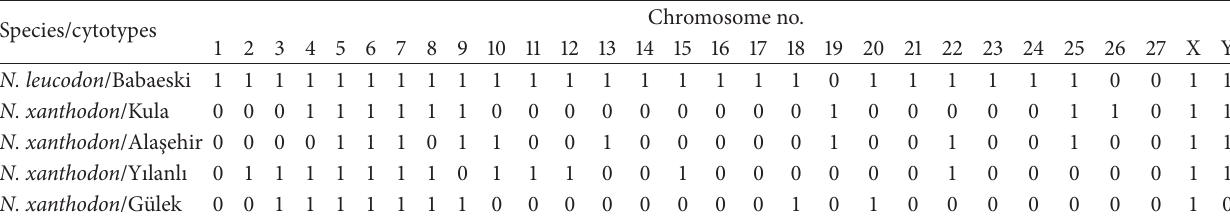
Table 2: The character distribution of the C-positive bands on individual chromosome pairs according to the presence (1) and absence (0). For population numbers see Table 1.